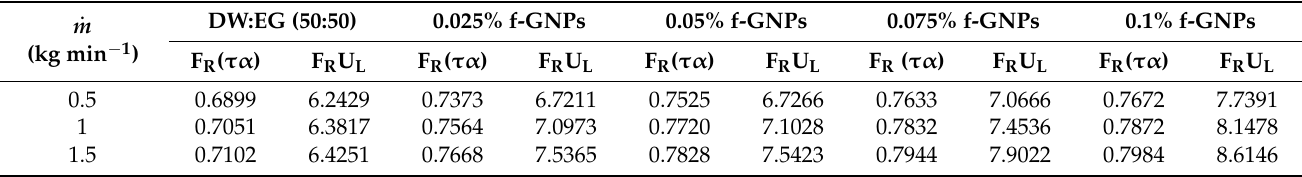
Table 4. Heat absorbed and heat removal factors at a different flow rate for the DW:EG (50:50)-based f-GNPs nanofluids. .